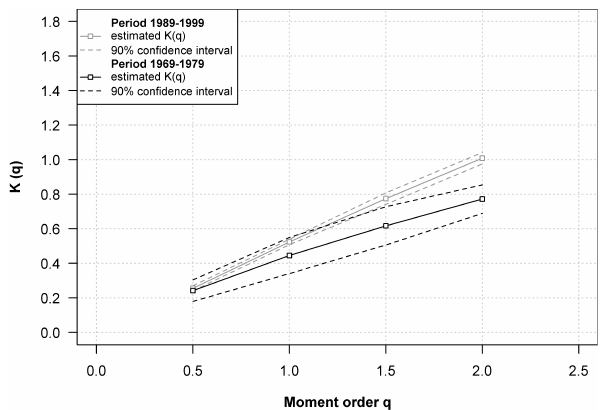
Fig. 4. Scaling exponent K(q) as estimated from the moment-scale relationship of rainfall data in the periods 1989–1999 (parameter- ization period) and 1969–1979 (validation period) for moments of order q ={ 0.5, 1, 1.5, 2 } .